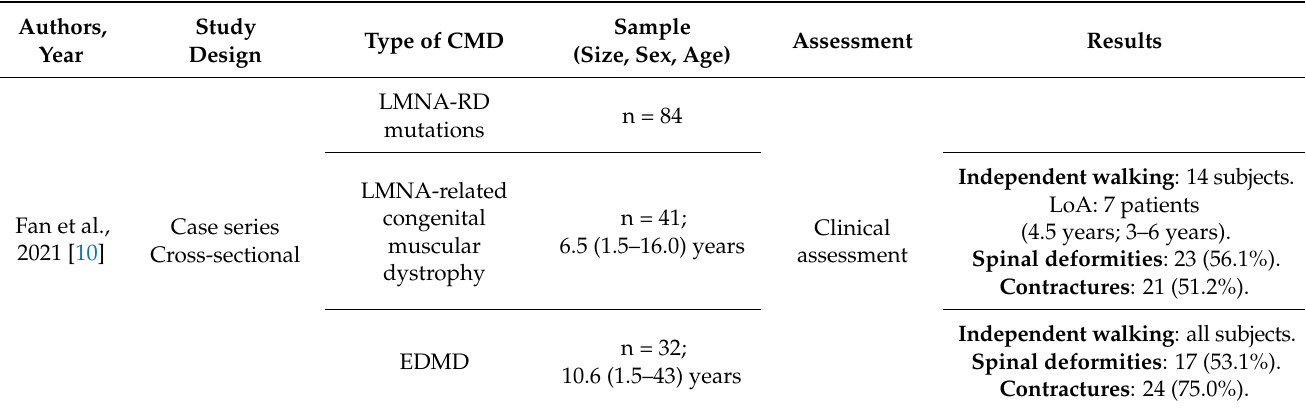
Table 2. Motor outcome measures in patients with LMNA-RD (EDMD: Emery–Dreifuss